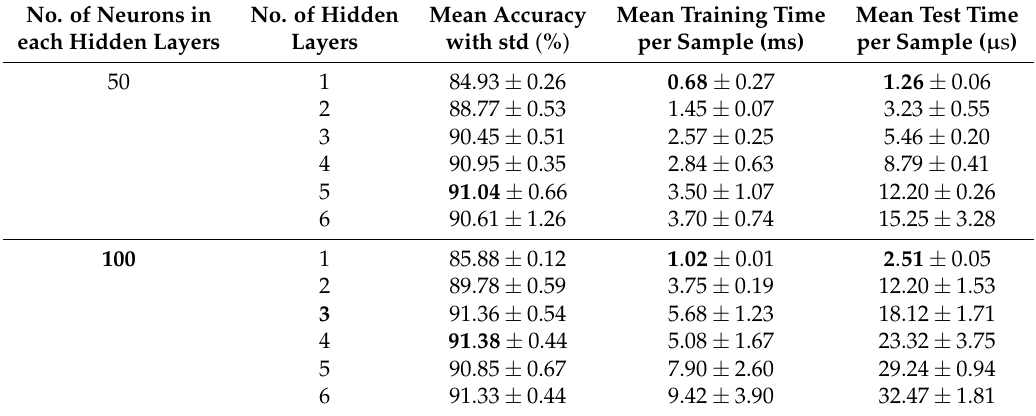
Table 4. Comparison of the MLP configurations based on the number of hidden layers and